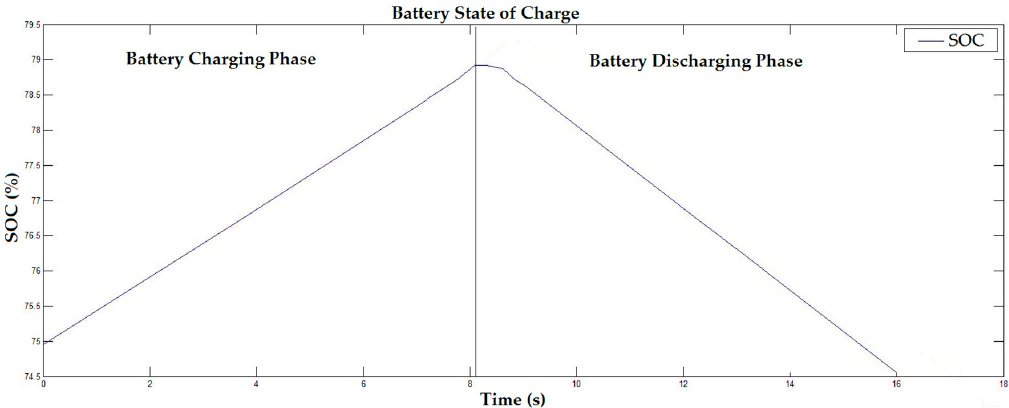
Figure 15 . Battery SOC in battery charging and discharging mode.